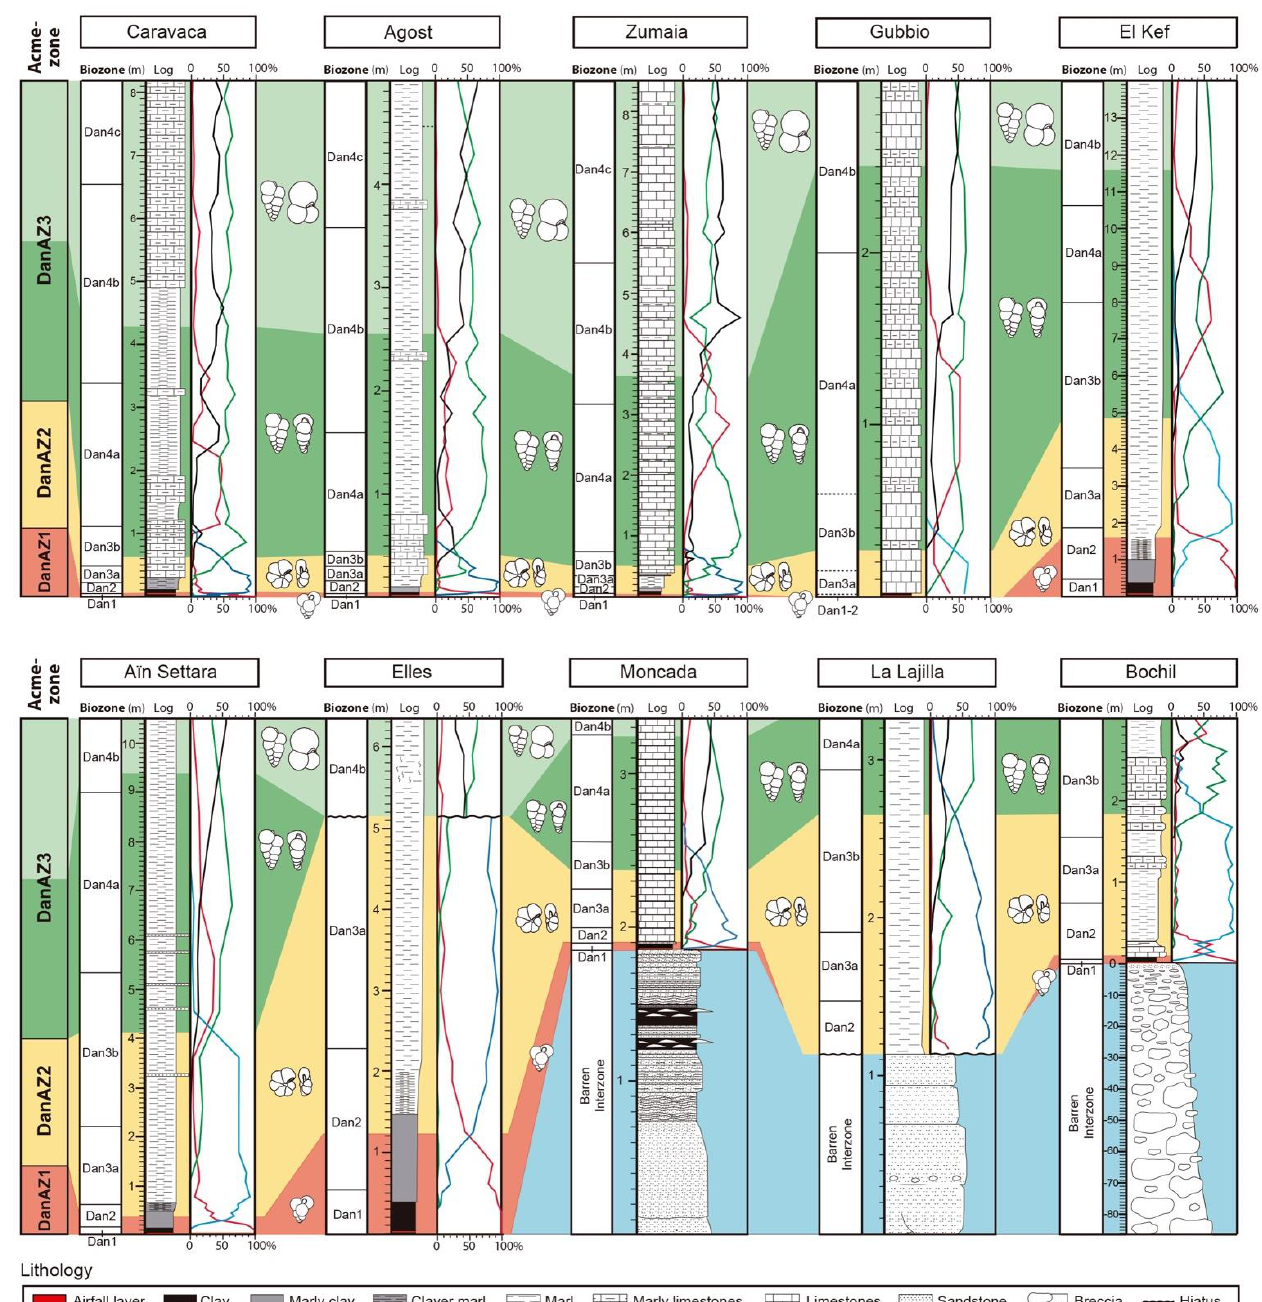
Figure 3. Planktic foraminiferal acme-zonation proposed in this report, and relative abundance of planktic foraminiferal groups across the lower Danian at the reference sections: Caravaca (middle bathyal; Spain) [8], Agost (upper-middle bathyal; Spain) [34], Zumaia (middle bathyal; Spain) [9], Gubbio (lower bathyal; Italy) [9], El Kef (outer sublittoral-upper bathyal; Tunisia) [40], Aïn Settara (outer sublittoral; Tunisia) [41], Elles (outer sublittoral; Tunisia) [43], Moncada (upper bathyal; Cuba) [46], La Lajilla (lower bathyal; Mexico) [44], and Bochil (upper bathyal; Mexico) [45]. Red line = triserial guembelitriid group ( Guembelitria and Chiloguembelitria ). Blue line = smooth-walled parvularugoglobigerinid group ( Parvularugoglobigerina , Palaeoglobigerina and Pseudocaucasina ). Green line = biserial group ( Woodringina and Chiloguembelina ). Black line = other genera ( Eoglobigerina , Globanomalina , Parasubbotina , Praemurica , Subbotina , Trochoguembelitria , and Globoconusa ). For Acme-zone DanAZ3, dark green shading: dominance of Woodringina-Chiloguembelina , and light green shading: codominance of Woodringina-Chiloguembelina and other genera ( Eoglobigerina - Subbotina - Parasubbotina-Globanomalina-Praemurica ).